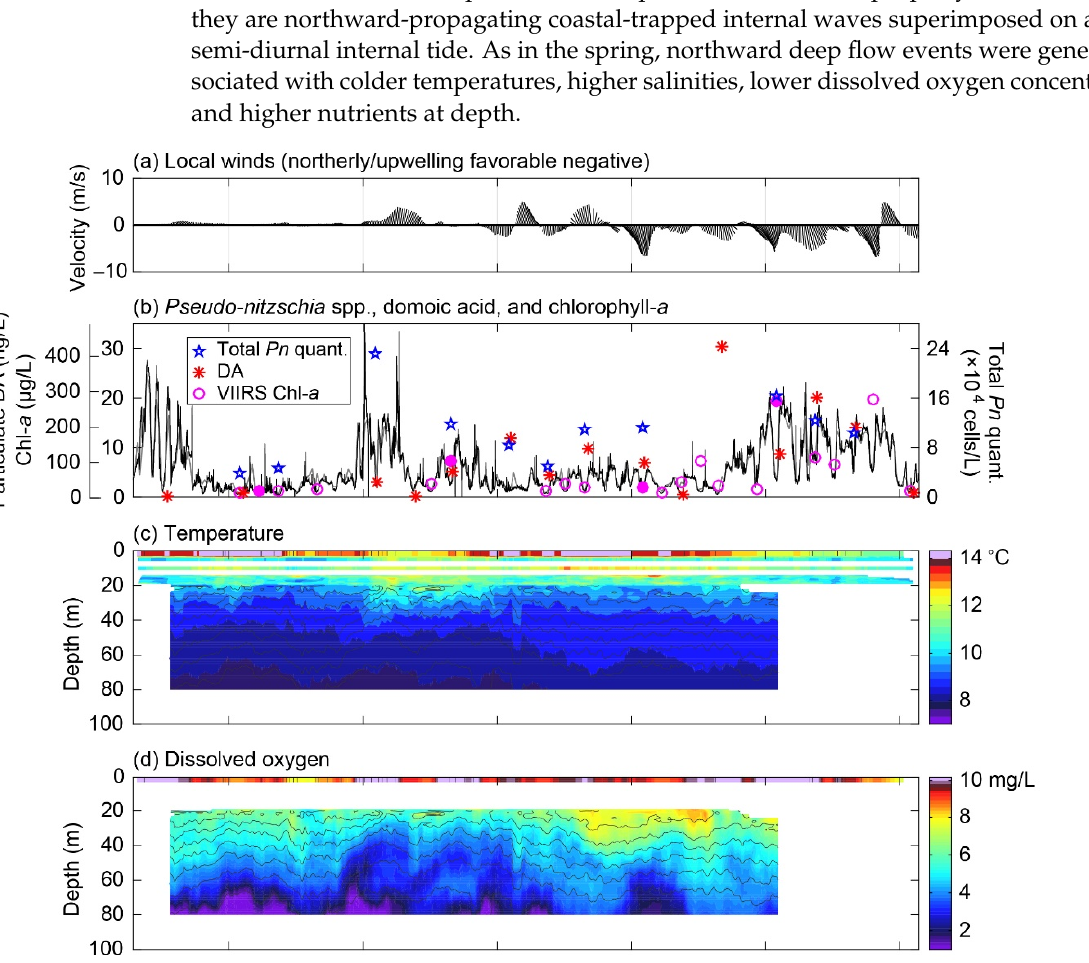
Figure 9. Biological and physico-chemical monitoring results from the ESP mooring and other platforms for the period 5 September to 15 October 2017. ( a ) 12-h smoothed near-surface (4 m) wind velocity vectors from the NDBC Cape Elizabeth buoy (46041), with the along-shelf direction (~345°T/165°T) aligned with the vertical axis. ( b ) Two independent measure- ments of chlorophyll- a concentrations at 1-m depth on the Cháb ă mooring (gray and black lines). Note the different scale on the vertical axes in panel b compared to Figure 7. VIIRS chlorophyll- a concentrations at the NEMO location are shown as magenta circles, with filled circles showing the times of satellite images shown in Figure 10. The concentration of par- ticulate domoic acid (DA) in seawater and total abundance of Pseudo-nitzschia spp. quantified during the deployment ( P. australis , P. fraudulenta , P. multiseries , and P. pungens ) are shown as red asterisks and blue stars, respectively. Depth-time maps of ( c ) temperature, ( d ) dissolved oxygen concentration, ( e ) nitrate concentration, and ( f ) along-shelf velocity, with salinity contours overplotted on each, as recorded by the NEMO-SS and Cháb ă moorings. Times are in Pacific Daylight Time (UTC-7) for all panels.